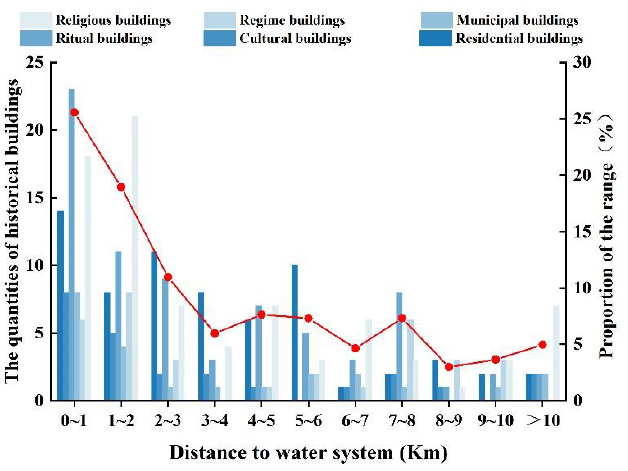
Figure 13. Quantity of each type of historical building distributed at different distances from the water system.